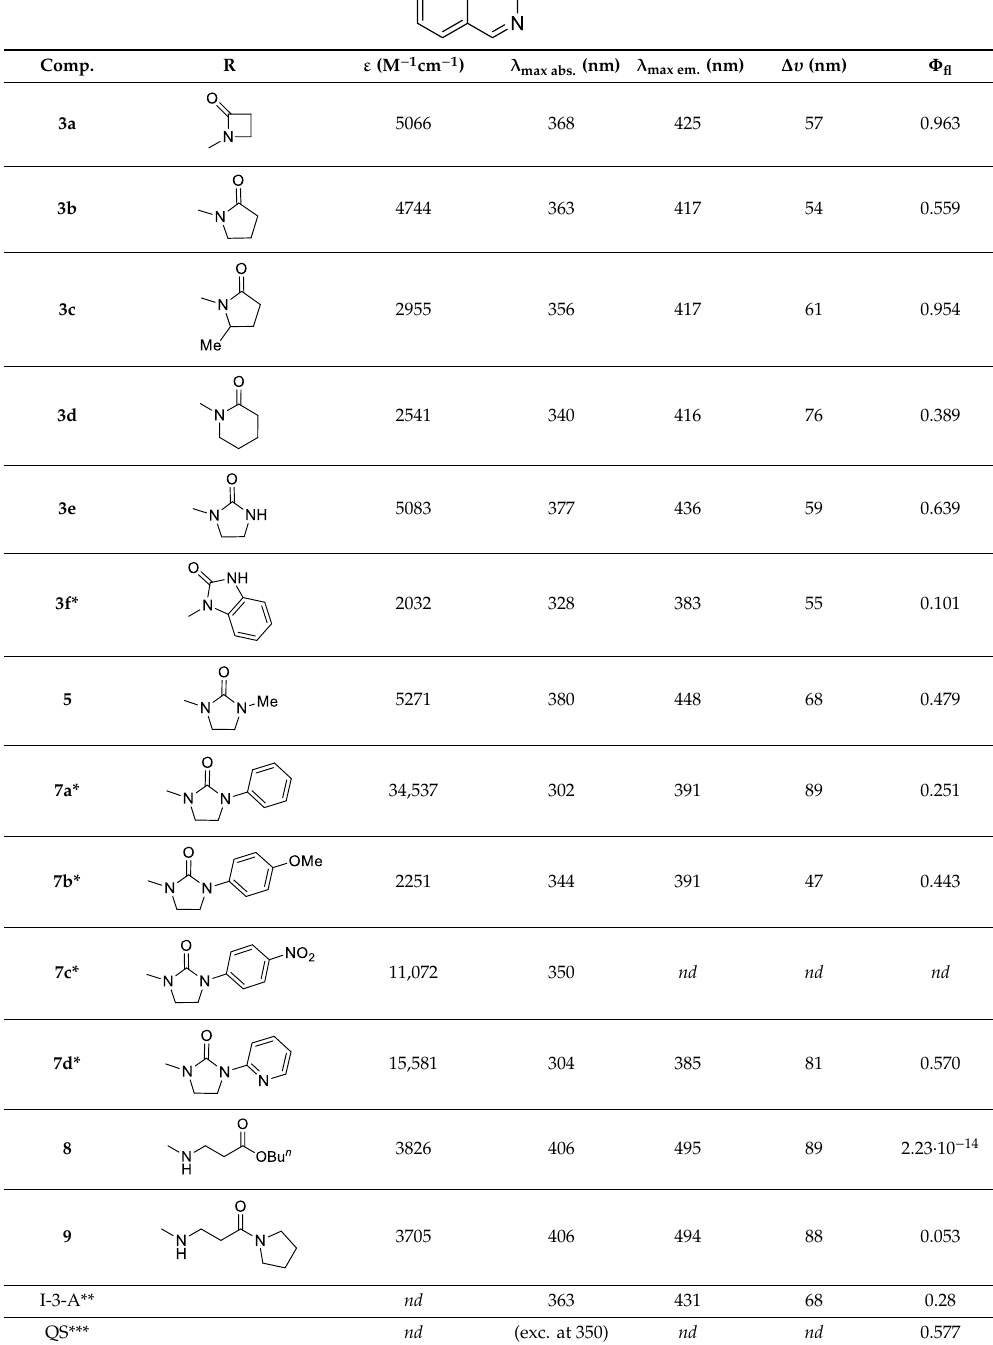
Table 1 . Photophysical properties: molar absorptivity ( ε) , absorption maxima ( λ max abs. ), emission maxima ( λ max em. ), Stokes shift ( Δ υ ) and fluorescence quantum yield ( Φ fl ) of the selected isoquinoline derivatives in 0.1 M H 2 SO 4 *.